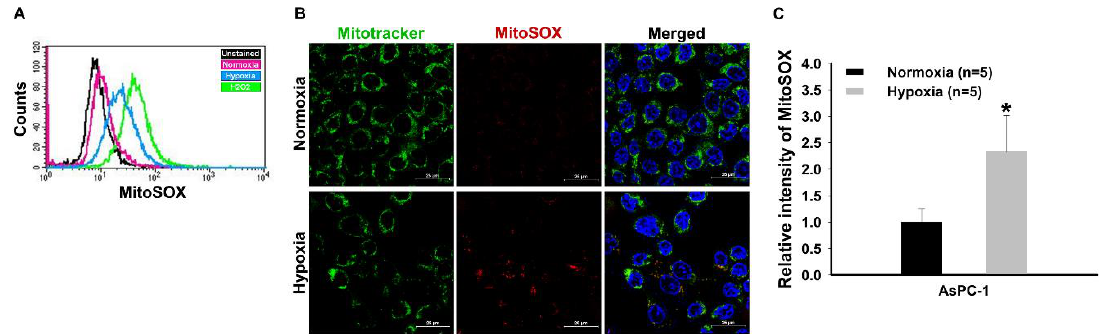
Figure 1. Flow cytometry and fluorescence-activated cell sorting analysis and immunofluorescence images for the detection of reactive oxygen species (ROS) in pancreatic cancer cells. ( A ) Mitochondrial superoxide indicator (MitoSOX)-based flow cytometry and fluorescence-activated cell sorting analysis detecting mitochondrial ROS. H 2 O 2 was used for positive control. ( B ) Immunofluorescence staining for detecting mitochondria reactive oxygen species (ROS) (MitoSOX). Mitochondria tracker (Mitotracker) and MitoSOX fluorogenic dye accumulation in pancreatic cancer cells under hypoxia. Each pixel exposure time 0.1 s. Scale bar = 25 µ m. ( C ) Quantitative analysis for mean fluorescent intensity of ROS generation between normoxia and hypoxia. The results were performed by quintuplicate obtaining repetitive results. A total of five cells with relatively high fluorescence intensity on one slide of each group was considered as a single analysis. * P < 0.05 vs. normoxia. Results are mean ± SD.